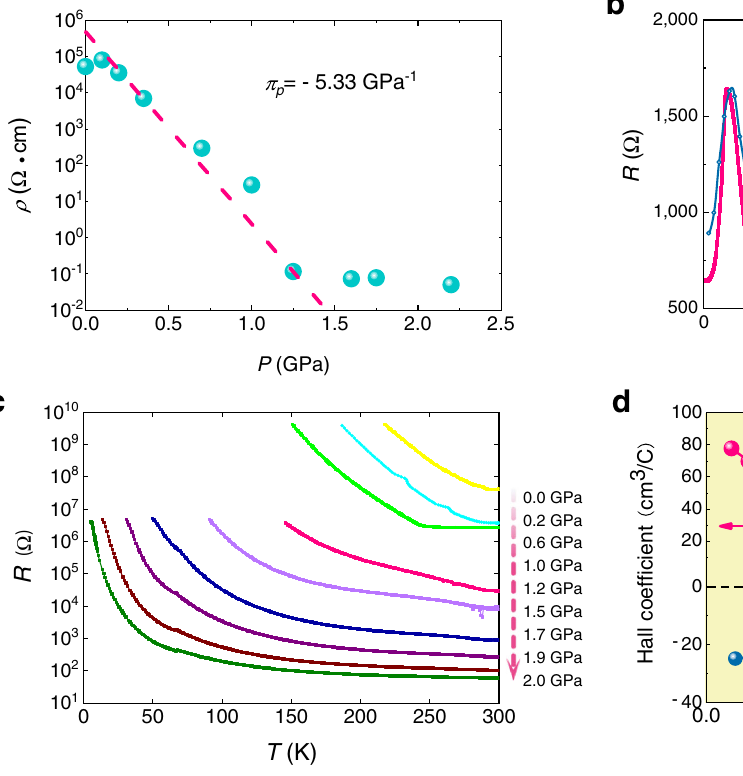
straight line on the semilog plot. b Dynamic piezoresistance measurement. c Temperature-dependentresistanceforpressuresof0~2.0GPa. d Hallcoef fi cient